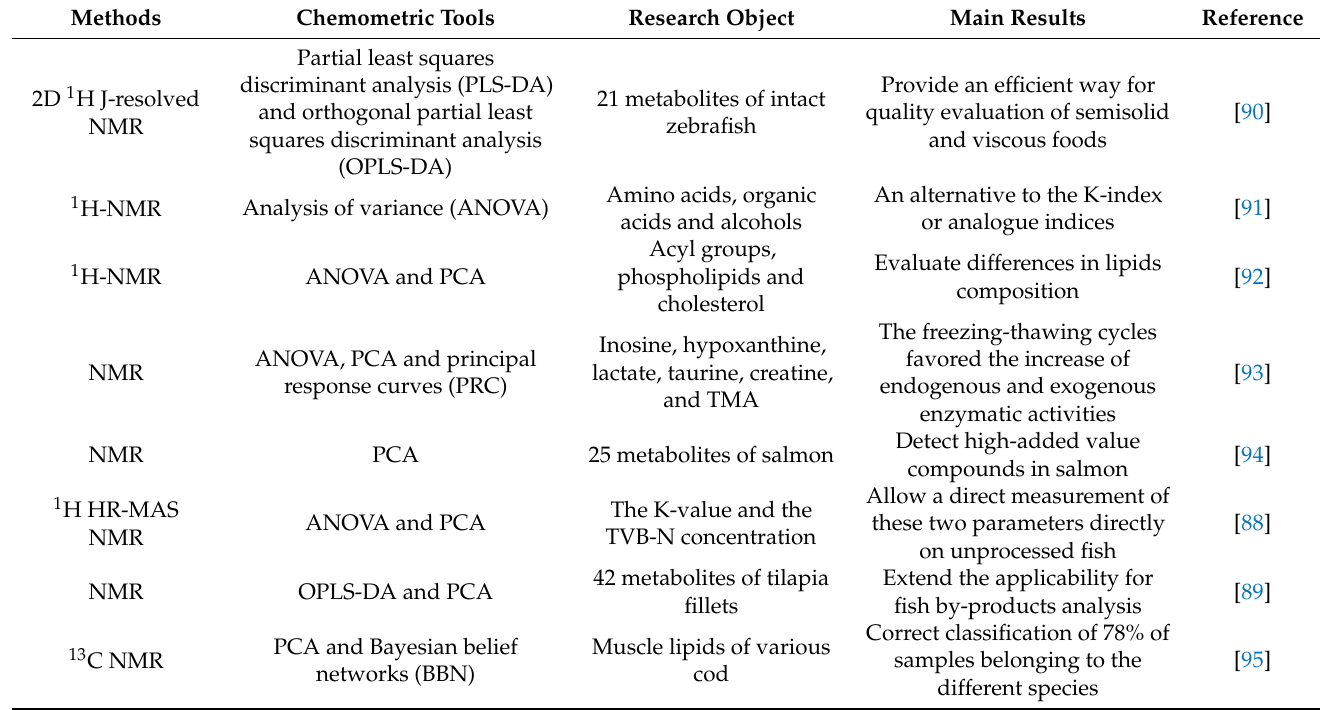
Table 2. Recent NMR techniques for fish freshness